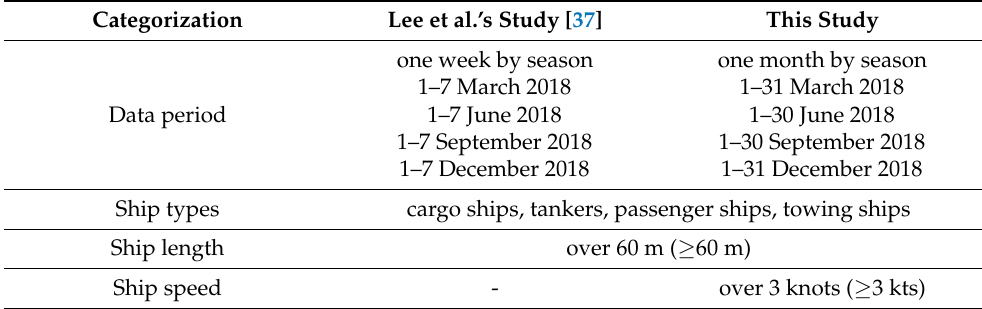
Table 2. Comparison of the AIS data used in the analysis of Lee et al. [37] and the present study. Categorization Lee et al.’s Study [37] This